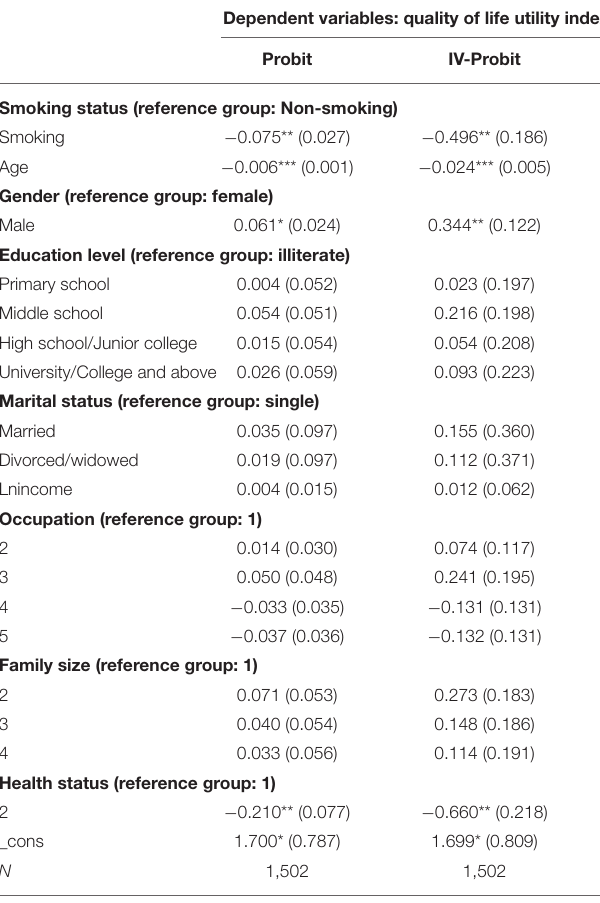
TABLE 2 | Sample characteristics according to smoking status ( N = 1,543). TABLE 3 | Effect of smoking on HRQoL: IV probit